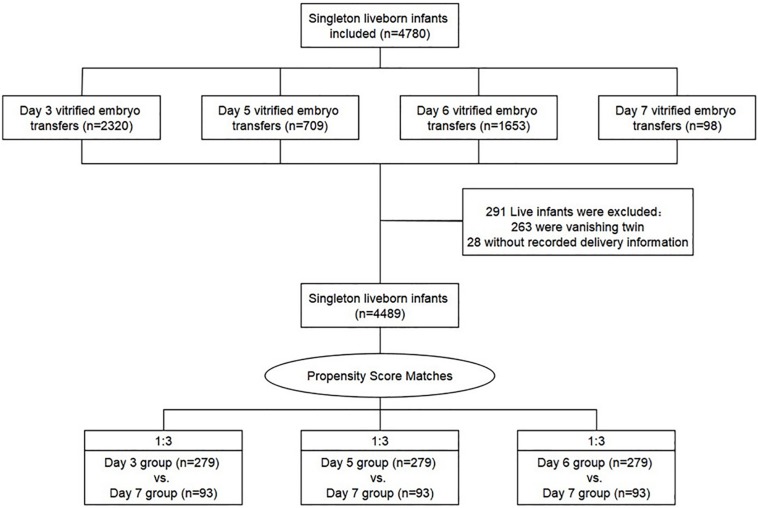
Flow chart of the study.